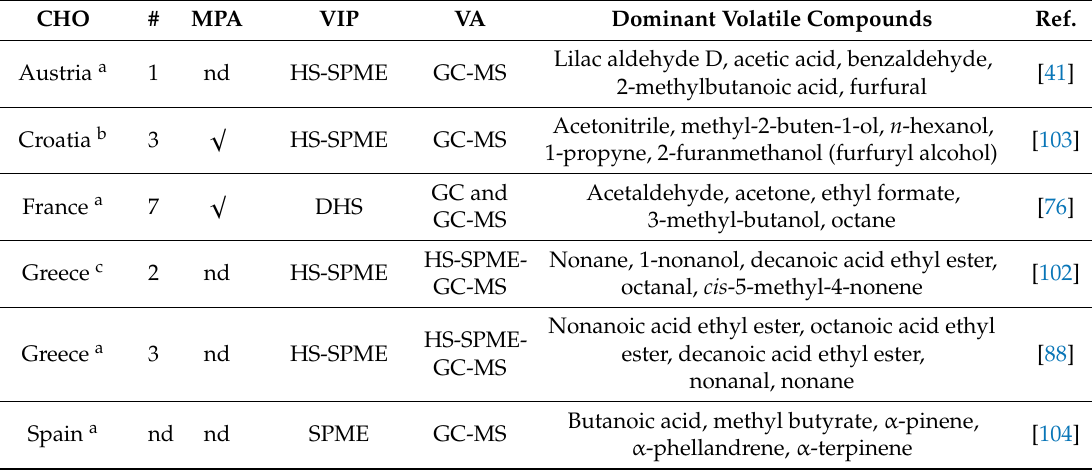
Table 9. Main volatiles of fir tree honey and honeydew, with reference to the country of origin, number of samples, isolation and analysis procedures and five main volatile components. Unless otherwise specified, the honeybee type was A. mellifera